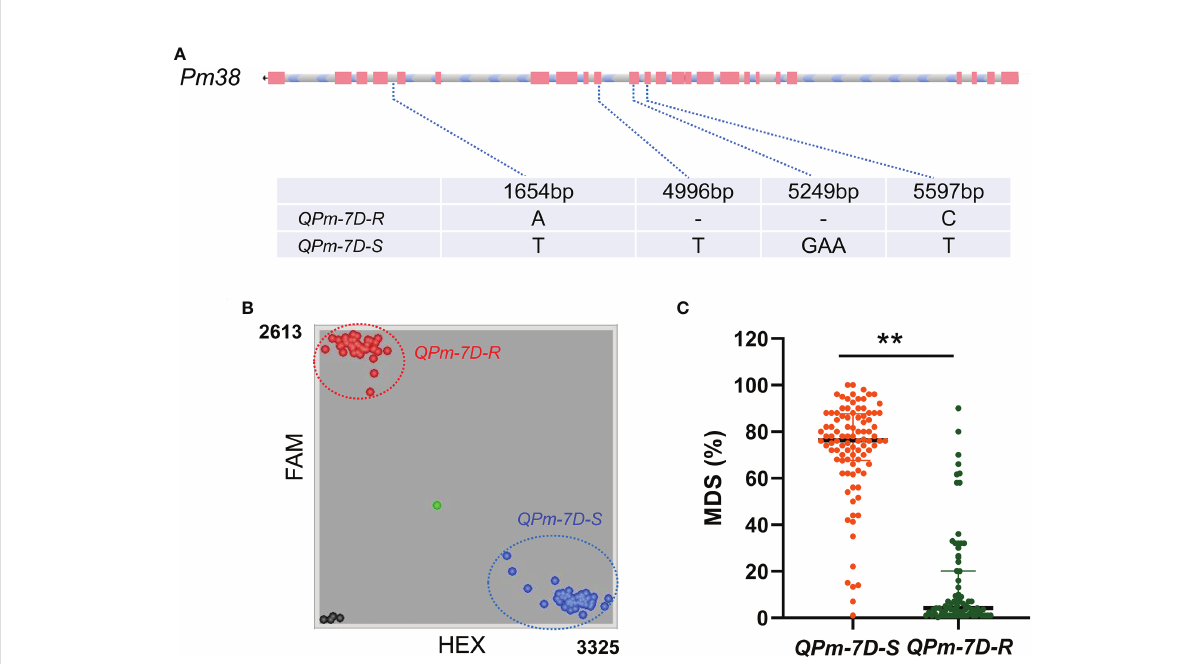
FIGURE 3 Haplotypes analysis with maximum disease severities (MDS) of QPm.cas-7D in PG-RIL population. (A) Haplotypes of QPm.cas-7D based on its genome regions in P3228 and Gao 8901. (B) Genotyping results of the diagnostic marker Kasp5249 developed for QPm-7D-R and QPm-7D-S haplotypes in the PG-RIL population. (C) Haplotypes analysis with MDS of Pm38 in the PG-RIL population. ** P < 0.01 (two-tailed t